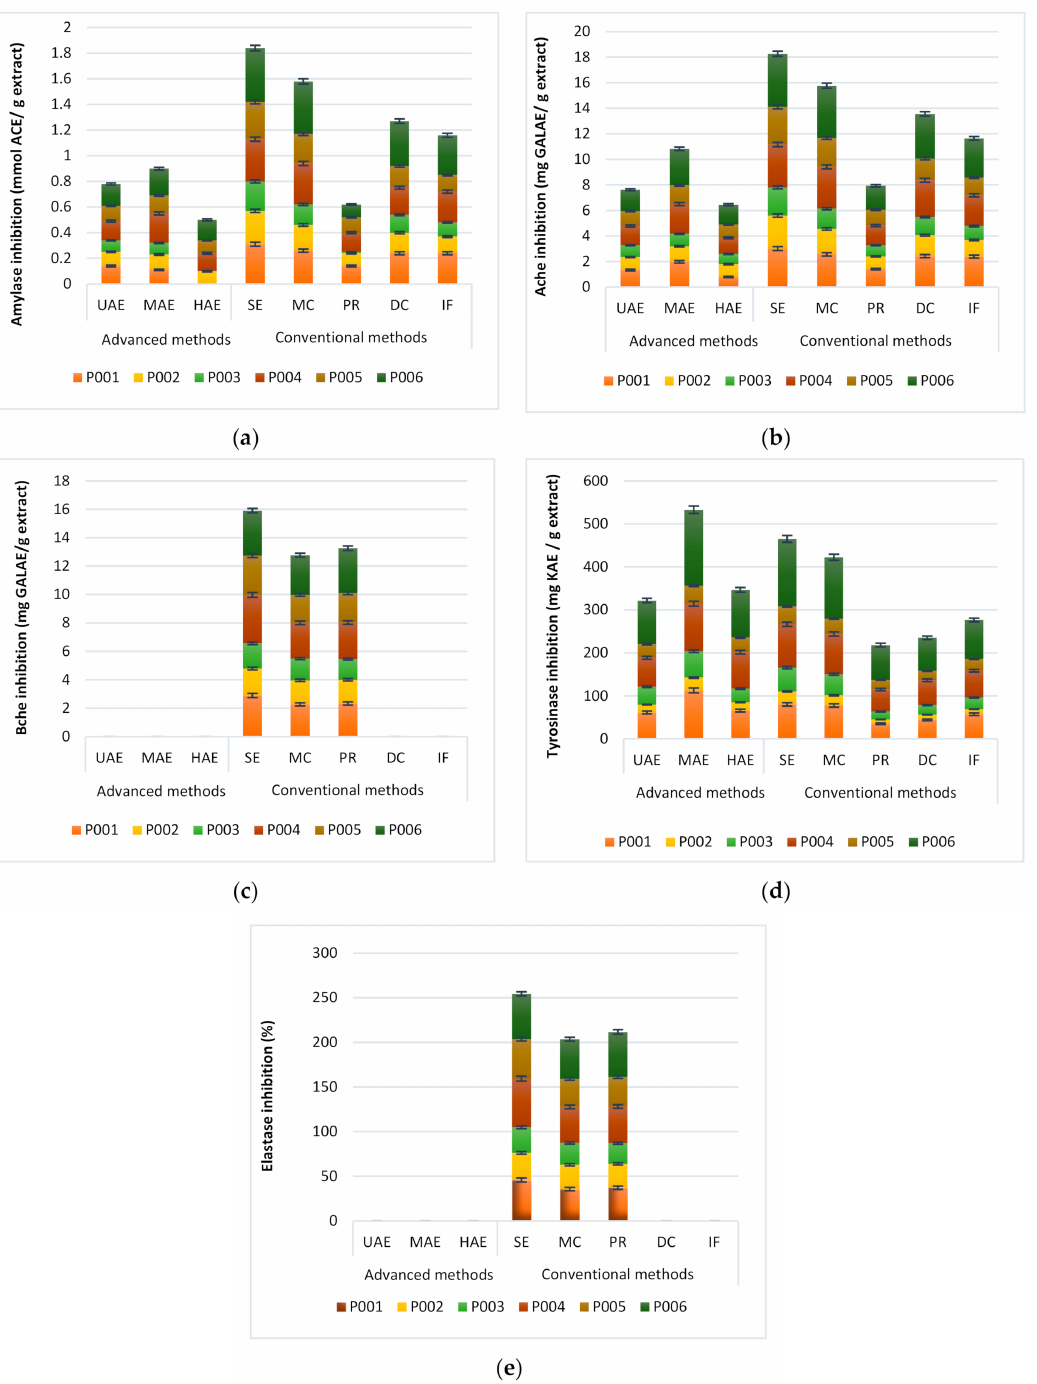
Figure 3. Enzyme inhibitory activities of MAP extracts obtained using conventional and non- conventional extraction techniques. Values are reported as mean ± standard deviation. The final concentration of tested extracts was 1 mg/mL. ( a ) α -amylase inhibition ability is presented as mmol acarbose equivalent per gram of MAPs extract (mmol ACE/g extract). ( b ) Acetylcholinesterase and ( c ) butyrylcholinesterase inhibitory activities are reported as milligrams galantamine equivalents per gram of MAPs extracts (mg GALAE/g extract). ( d ) Tyrosinase enzyme inhibitory is presented as kojic acid equivalent per gram of MAPs extracts (mg KAE/g extract). ( e ) Elastase enzyme inhibitory activity is reported in percentage (%). (P001) Corrigiola litoralis (L.), (P002) Tamarix aphylla (L. H.), (P003) Pistacia lentiscus (L.), (P004) Cyperus rotundus (L.), (P005) Nardostachys jatamansi (D. Don, DC.), and (P006) Lavandula coronopifolia